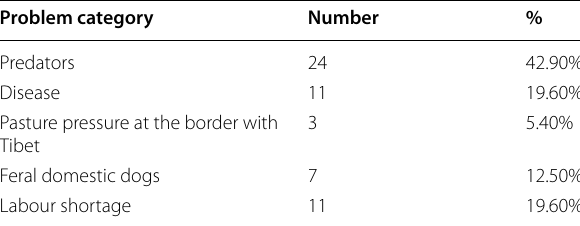
Table 2 Yak tending problems faced by herders Problem